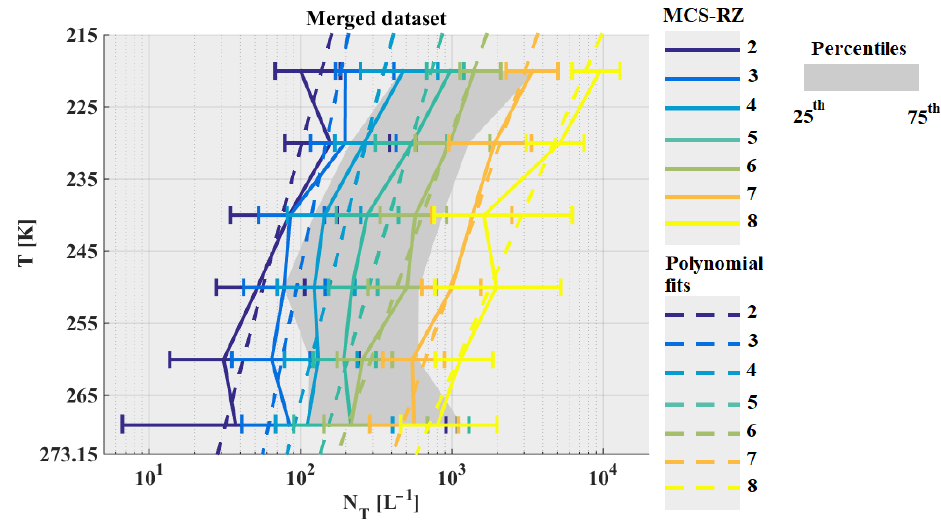
Figure A1. The same as Fig. 5 but for concentrations of hydrometeors integrated beyond D max = 15µm in L − 1 .